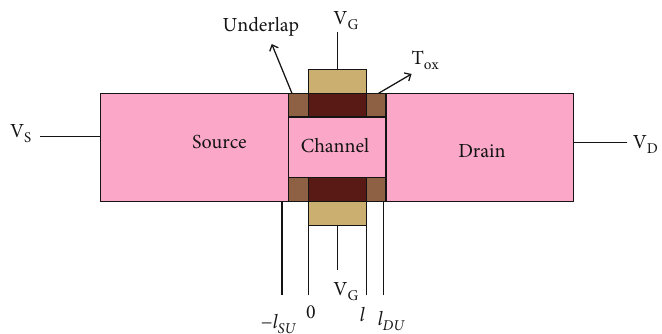
Figure 4: Two-dimensional underlap FinFET